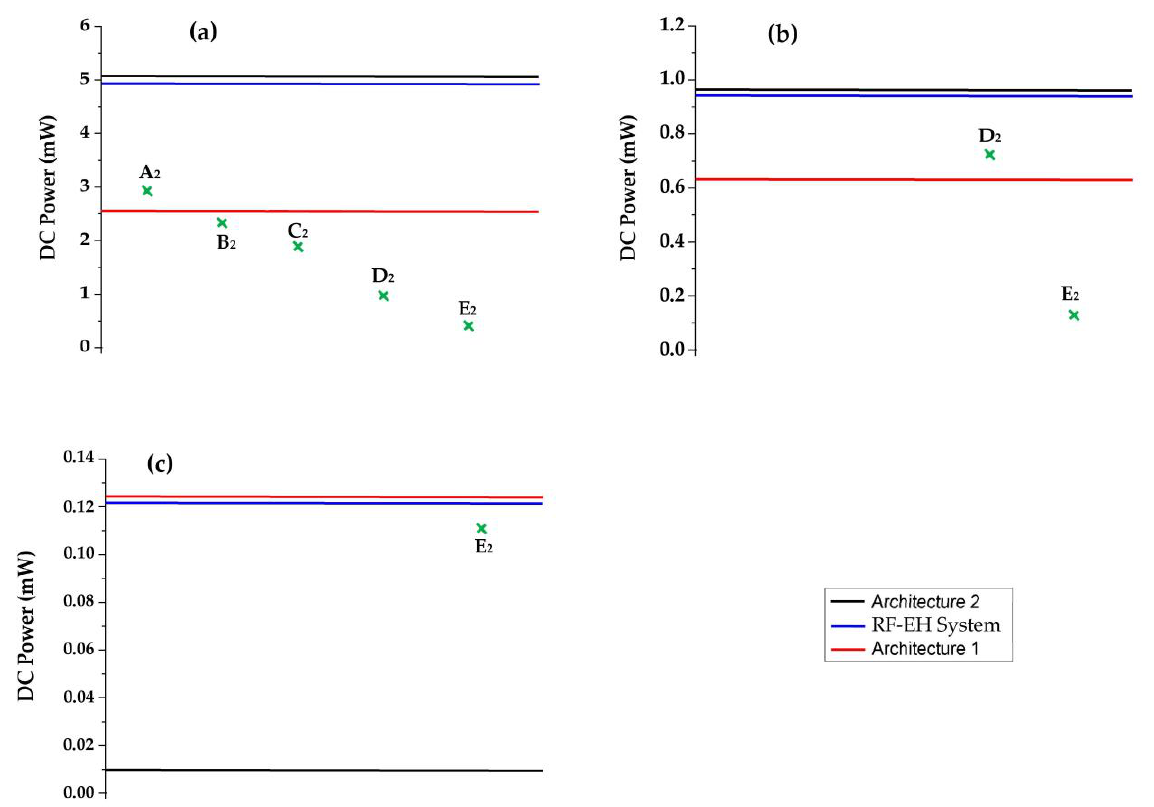
Figure 32. Feeding ability of the RF-EH system and architectures at ( a ): 22 m, ( b ): 40 m, and ( c ): 110 m from relay antenna compared to minimum required power supply of the image sensors. The DC powers A 2 , B 2 , C 2 , D 2 and E 2 correspond to the power supply of sensors proposed in the references [31–35], respectively .